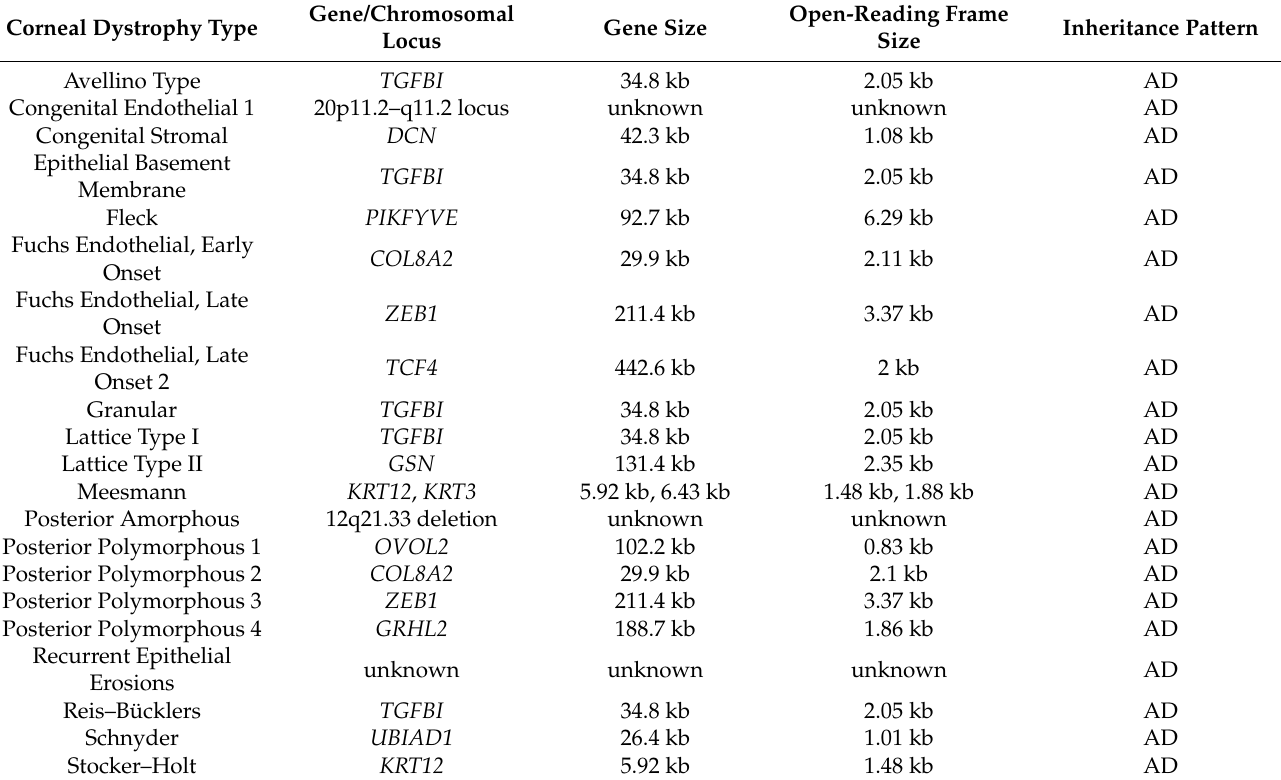
Table 3. Corneal dystrophies and their identified gene